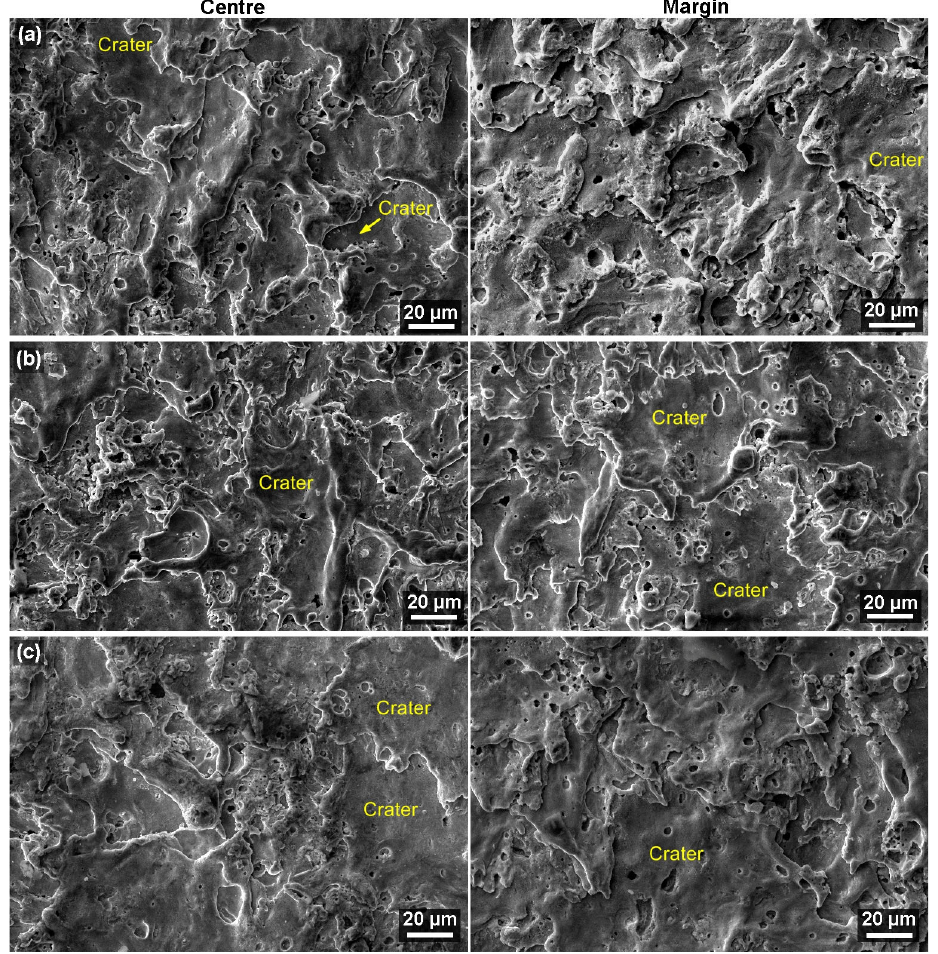
Figure 6. Surface morphology of individual samples at the margin or in the center of SEM/SE, ( a ) sample with a thickness of 5 mm, ( b ) sample with a thickness of 35 mm, ( c ) sample with a thickness of 70 mm.